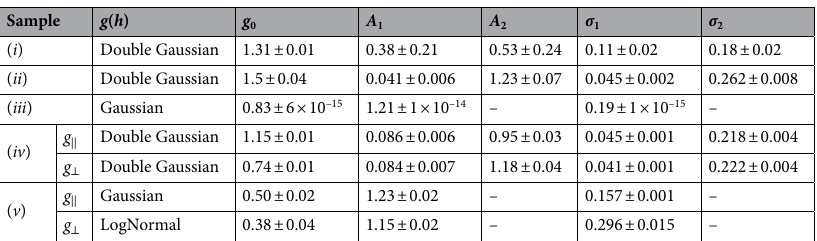
Table 2. Fit data of the connection functions g ( h ) of all samples at T = 15